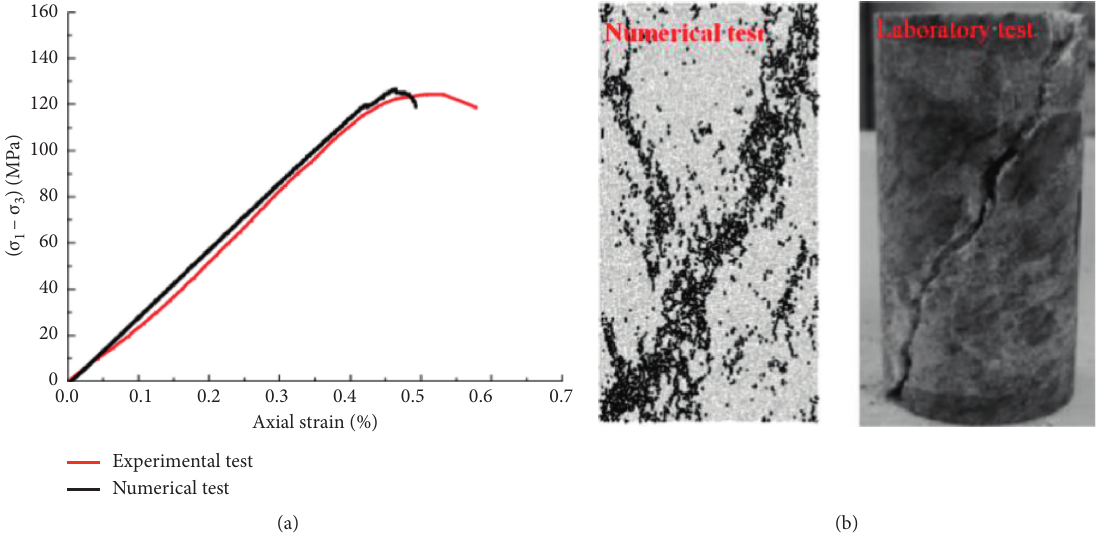
Figure 2: Comparisons of stress-strain curves and failure patterns between experimental and numerical results [38, 39]. (a) Stress-strain curve comparison. (b) Failure pattern comparison.